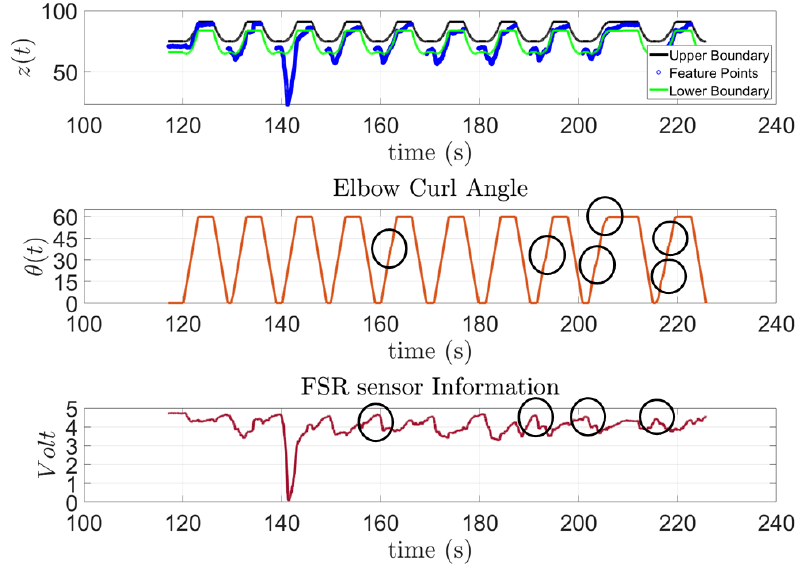
Figure 15. Subject 1: AAN through elbow flexion